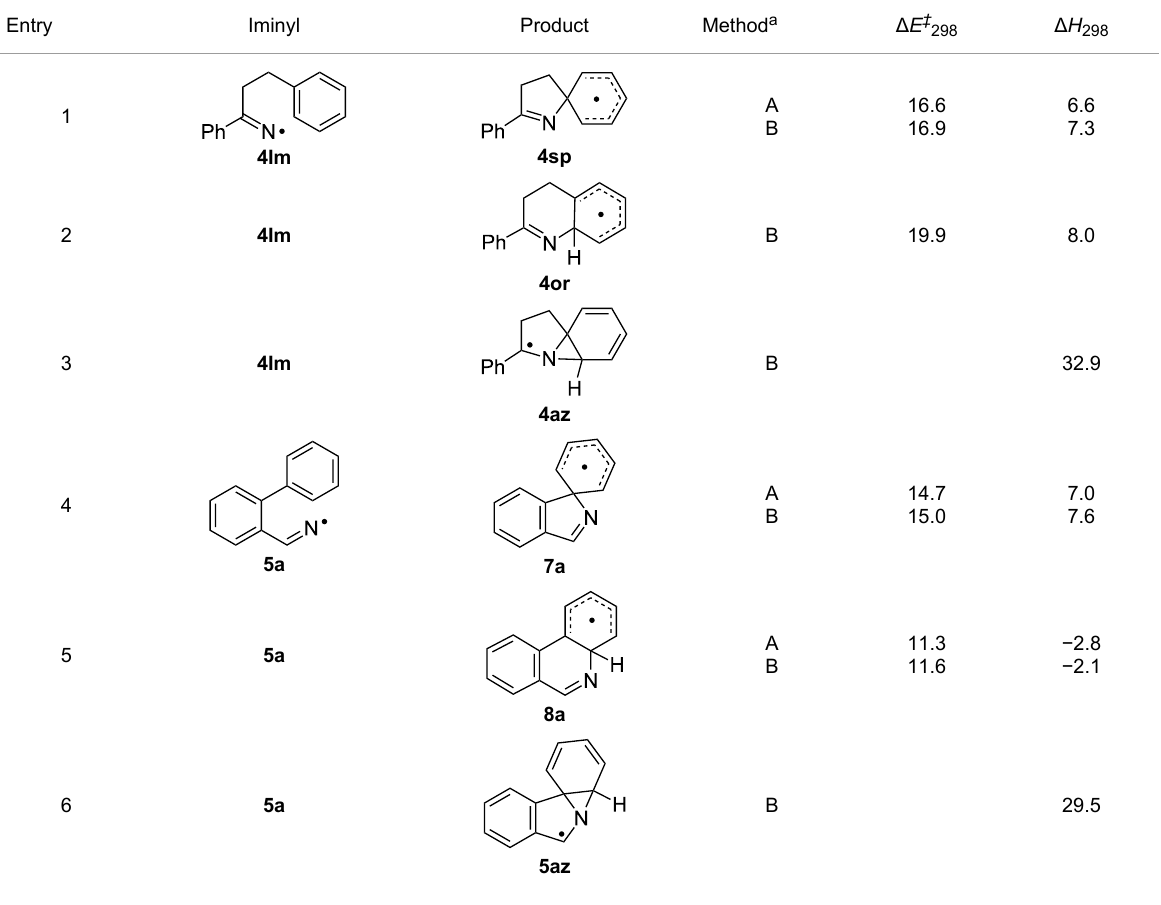
Table 4: DFT computed activation energies ( Δ E ‡ 298 ) and reaction enthalpies ( Δ H 298 ) in kcal mol − 1 for aromatic iminyl